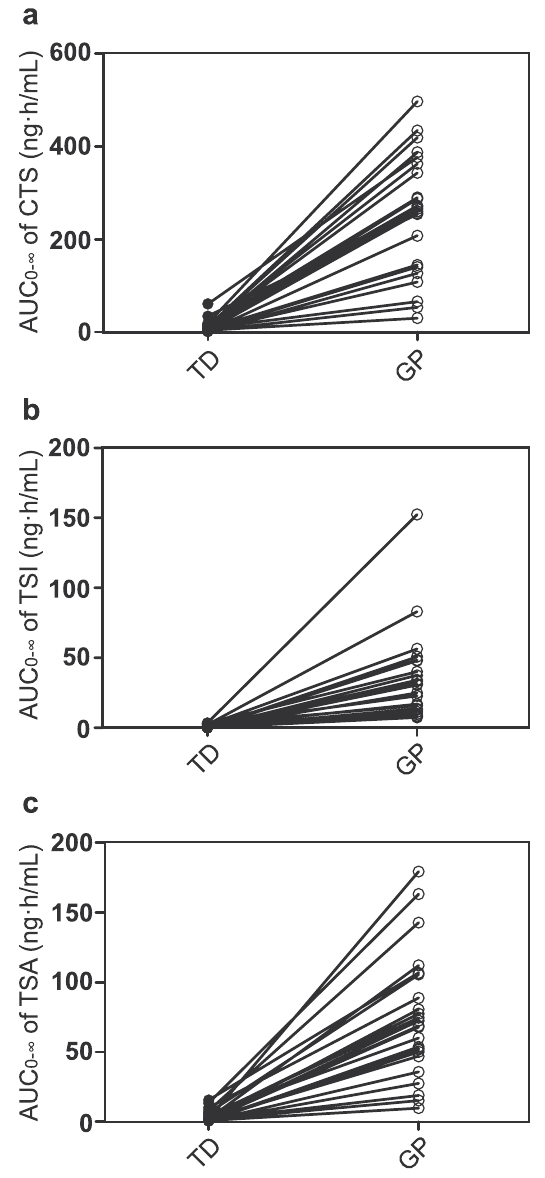
Figure 5. Comparison of individual area under the plasma concentration–time curve (AUC) values of cryptotanshinone ( a ), tanshinone I ( b ) and tanshinone IIA ( c ) obtained after granule powder (GP) and traditional decoction (TD) administration of Salvia miltiorrhiza . Each line in the plots represents an individual study participant. Plots with filled circles represent the AUC 0 −∞ of traditional decoction (TD), and those with open circles represent the AUC 0 −∞ of granule powder